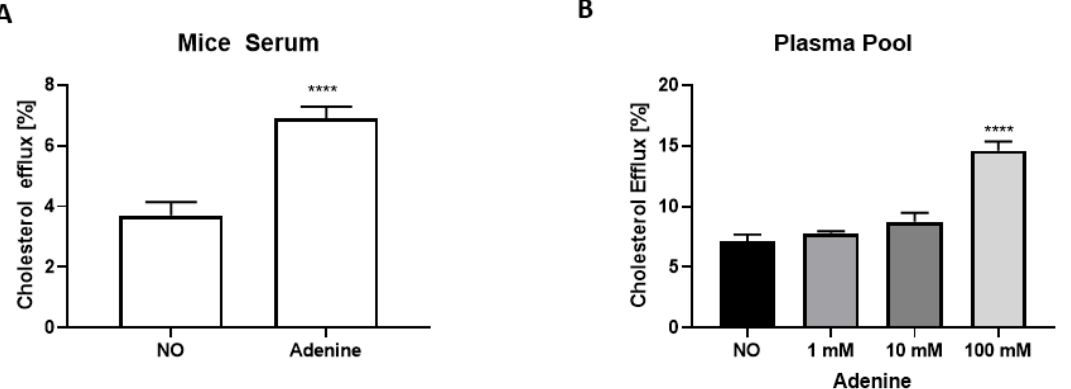
Figure 4. Adenine enhances cholesterol efflux. ( A ) Cholesterol efflux in RAW-365.7 cells using serum obtained from ApoE KO mice with normal renal function or with adenine-induced nephropathy. Data are means ± SEM ( n = 9–11). ( B ) Cholesterol efflux in RAW264.7 cells pre-incubated with increasing concentrations of adenine ( n = 4) with plasma pool as acceptor. NO represents the control group fed with WD-CAC. For statistical significance, **** p <